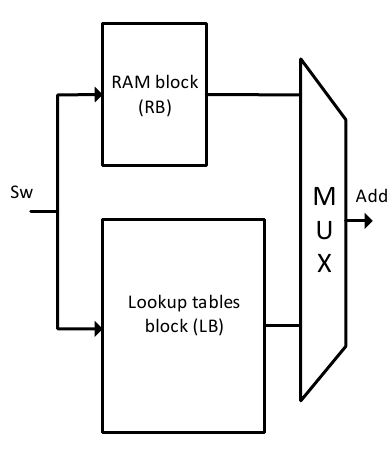
Figure 2. Dividing of the CAM design in two blocks to save power consumption. (Sw: Search word, Add: Output address where the search word is found).